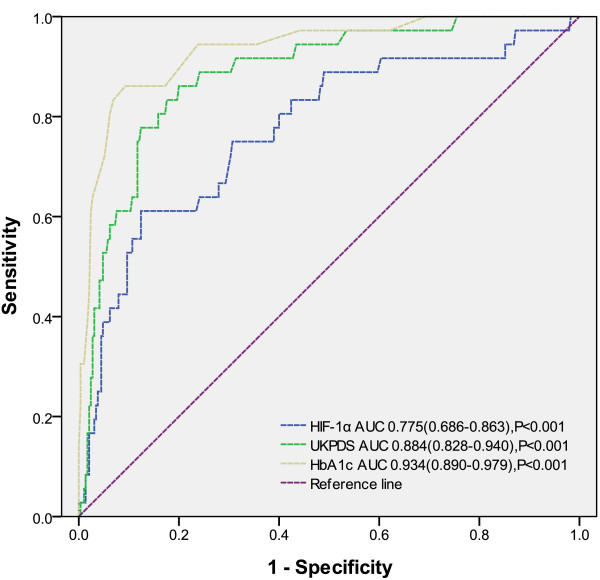
Receiver-operating characteristic curve analysis showing the prognostic value of HIF-1α levels, and United Kingdom Prospective Diabetes Study nUKPDS) and HbA1c in predicting severe and extensive calcification (CAC score > 400). The 95% confidence intervals are provided. AUC = area under the curve.